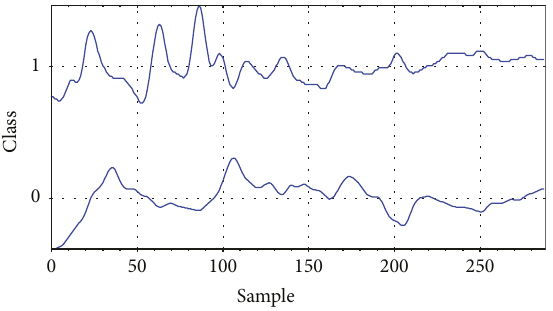
Figure 4: Example of records from each of the 2 classes of the CGM dataset. Contiguous equal values are clearly visible at the end of the top record featuring class